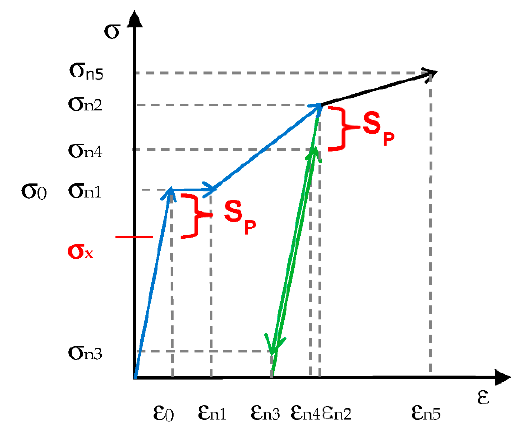
Figure 8. Example of strain hardening (multilinear) [12].